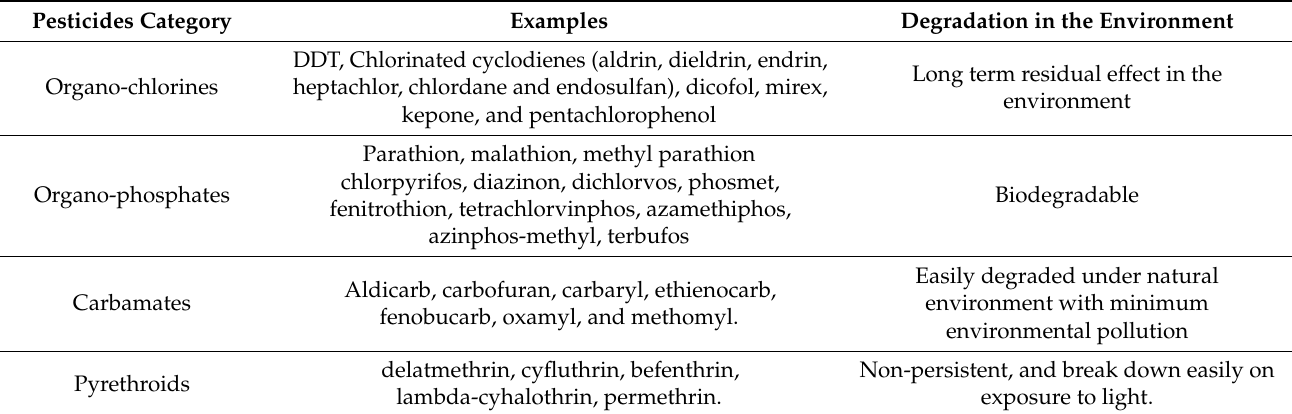
Table 1. Four categories of pesticides classified by chemical